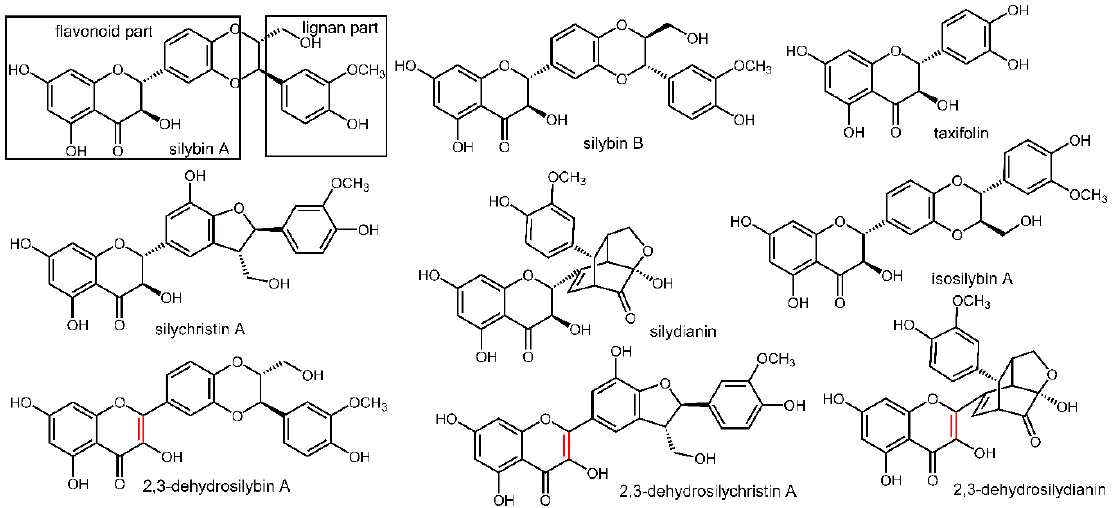
Figure 1. Selected silymarin